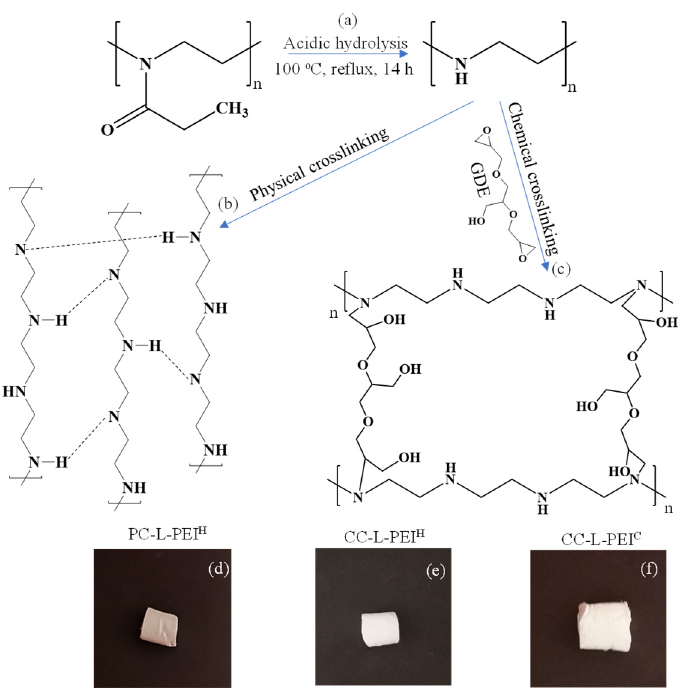
Figure 1. The schematic presentation of the synthesis of ( a ) L-PEI chains, ( b ) PC-L-PEI H , and ( c ) CC-L-PEI H /CC-L-PEI C , and digital camera images of ( d ) PC-L-PEI H , ( e ) CC-L-PEI H , and ( f ) CC-L-PEI C .